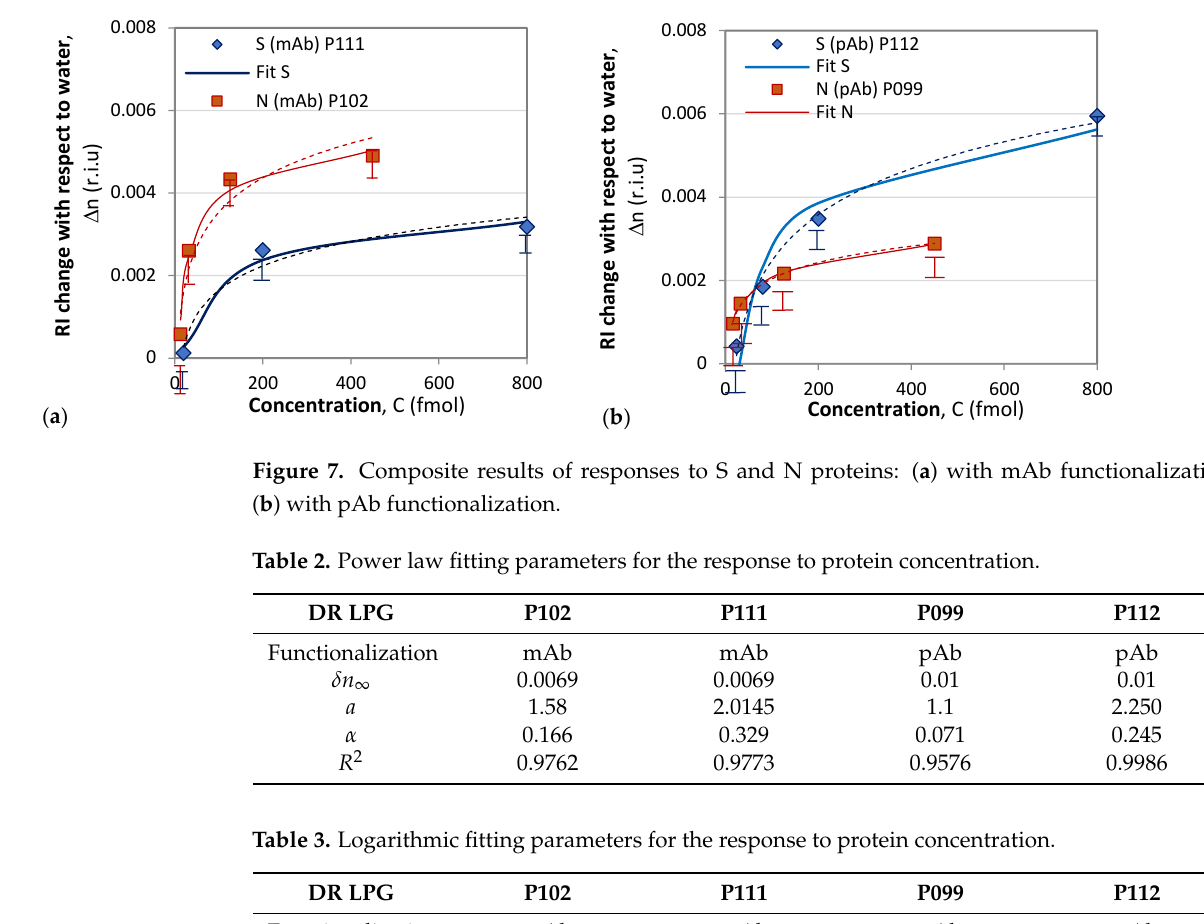
Figure 6. Change in spectrum under four different concentrations of S protein of the P112 grating functionalized with pAb.